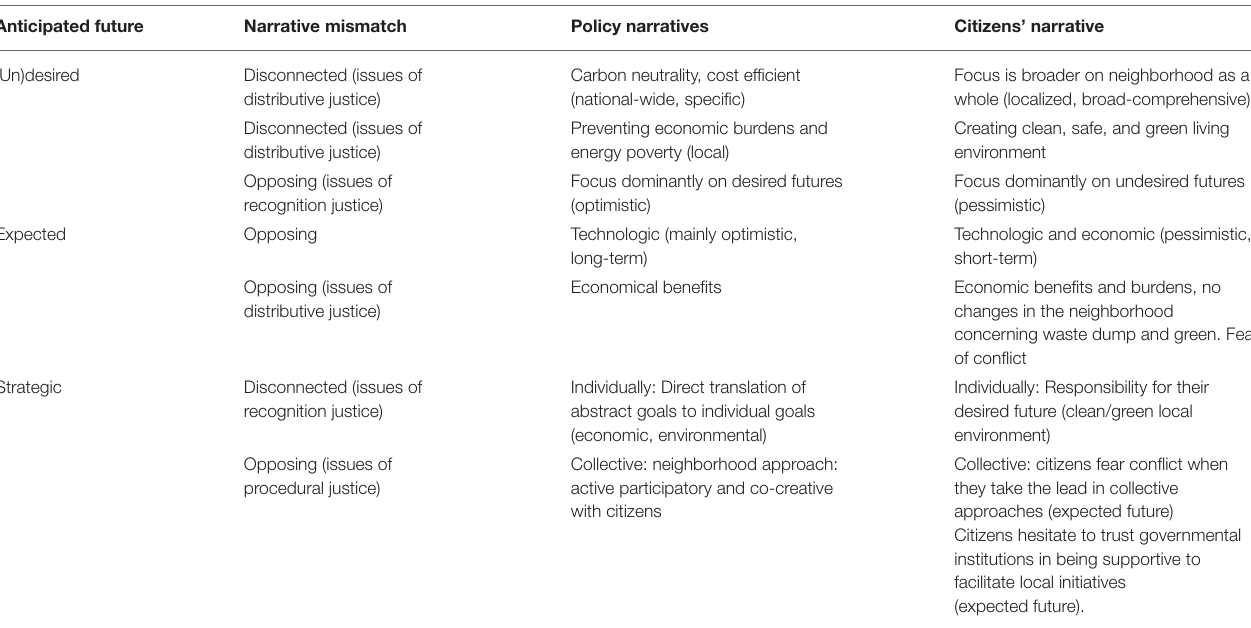
TABLE 2 | Overview of mismatches between future narratives in policy and